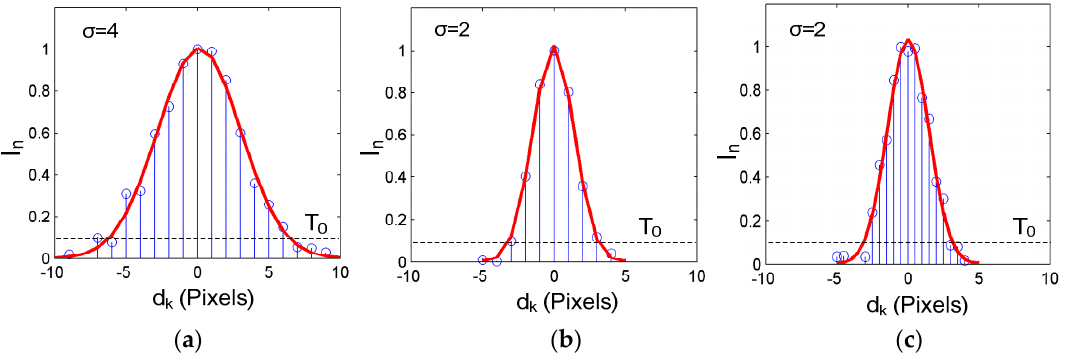
Figure 2. Normalized cross-section profiles at different simulation parameters: ( a ) σ = 4 and s p = 1; ( b ) σ = 2 and s p = 1; ( c ) σ = 2 and s p = 0.2.